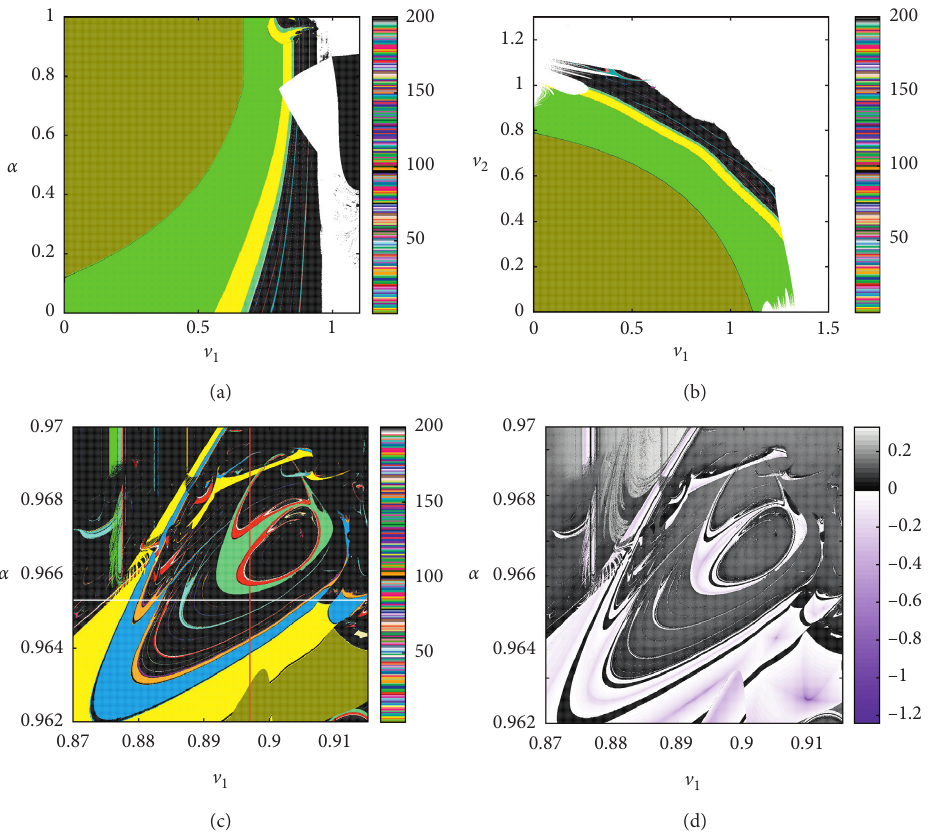
Figure 2: The chart of dynamic modes and the corresponding chart of the largest Lyapunov exponent under parameters a − c a − c � 3 . 5, b � 0 . 4, and β � 0 . 5. (a) The chart of dynamic modes of parameters space ( v 2 ,v ) , where α � 0 . 09644163. (c) Partial enlargement of (a). (d) The corresponding chart of the largest modes of parameters space ( v 1 2 Lyapunov exponent of